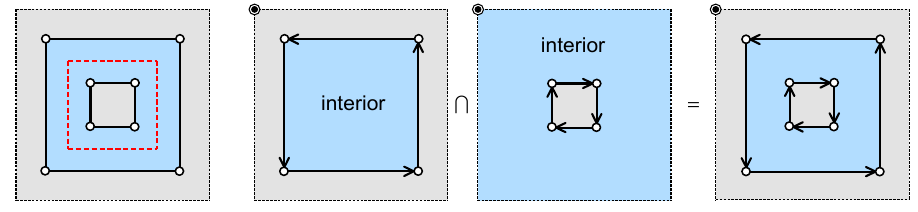
Figure 8. Multiply connected face.